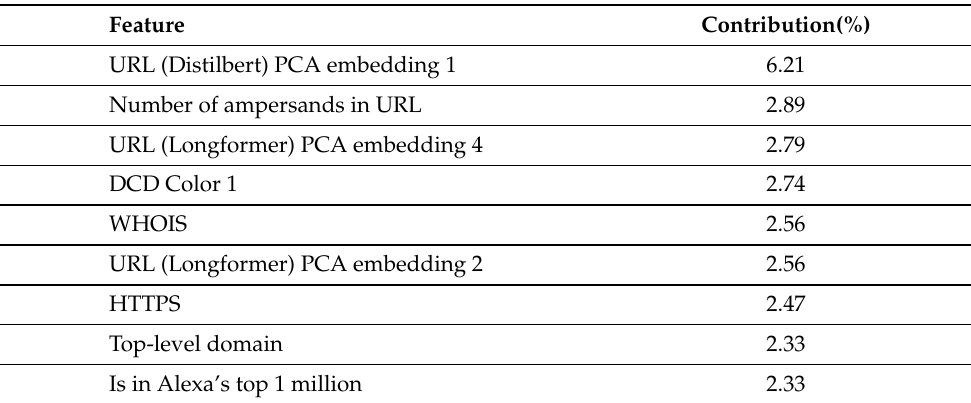
Table 6. Top 10 Contributing Features (with PCA 10 components